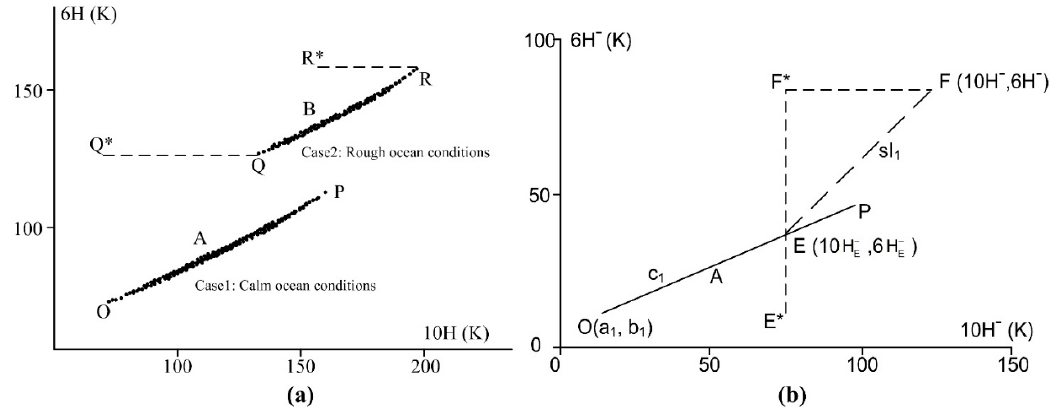
Figure 1. ( a ) Brightness temperature data of 6H and 10H, group A for calm ocean conditions and group B for rough ocean conditions; ( b ) Thematic figure drawn from ( a ). The two figures can be found in [15].